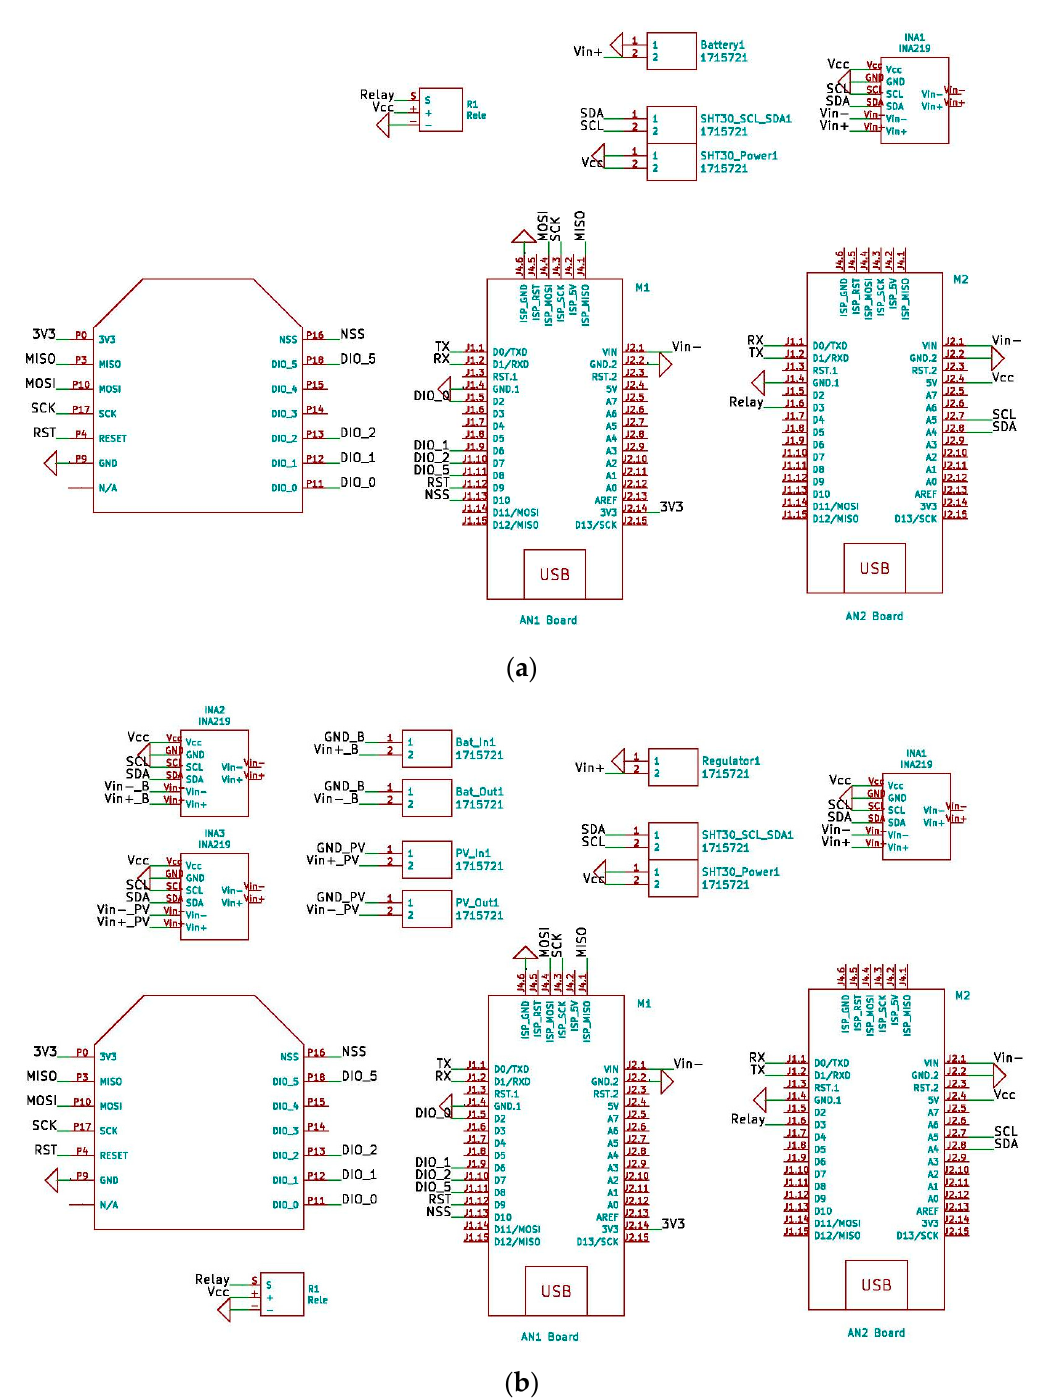
Figure 11. Schematic of the ECDL: ( a ) battery power supply and ( b ) battery and solar panel power supply. The economic valuation for the ECDL versions has also been done to verify that the reduced-price target has been met. Tables 9 and 10 give the approximate cost of the two ECDL